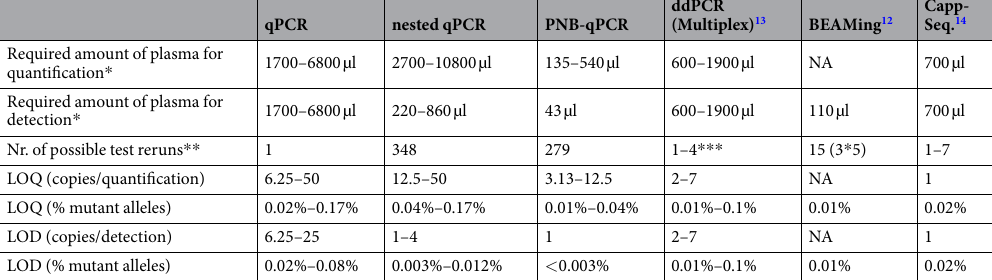
Table 1. Input requirements and specificities of selected detection methods. The Table summarizes various applications for detection and quantification of mutated DNA fragments, in our case KRAS , by providing the calculated minimum amount of plasma for positive test results, the possible number of repetitions of the test, as well as sensitivity of quantification (limit of quantification, LOQ) and detection (limit of detection, LOD). The required amount of plasma describes the necessary input volume into the isolation step for the method to produce reliable results and is determined by the used template volume, DNA concentration, and sensitivity. For the DNA isolation step, we calculated with a variable input volume and an output volume of 50 µ l as template for the detection methods. The number of possible reruns results from the required input volume of the methods and possible pre-amplification steps. It describes, how often a test can be repeated to control the results from a given template volume (in this case 50 µ l). The results in the three columns to the left refer to the methods presented in this publication. All calculations and percentages of sensitivity are based on numbers presented in the respective literature. * For 1 detection of all 8 variants, given 10 ng cfDNA/ml plasma and